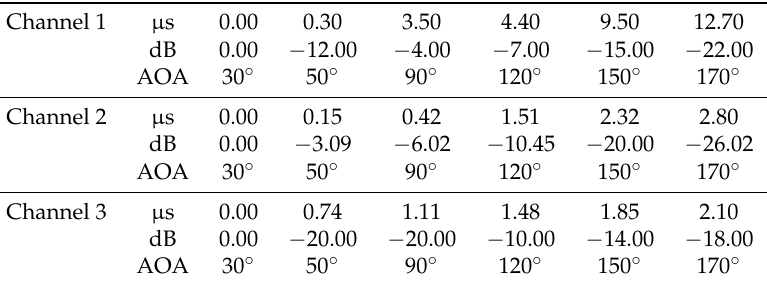
Table 3. Simulated